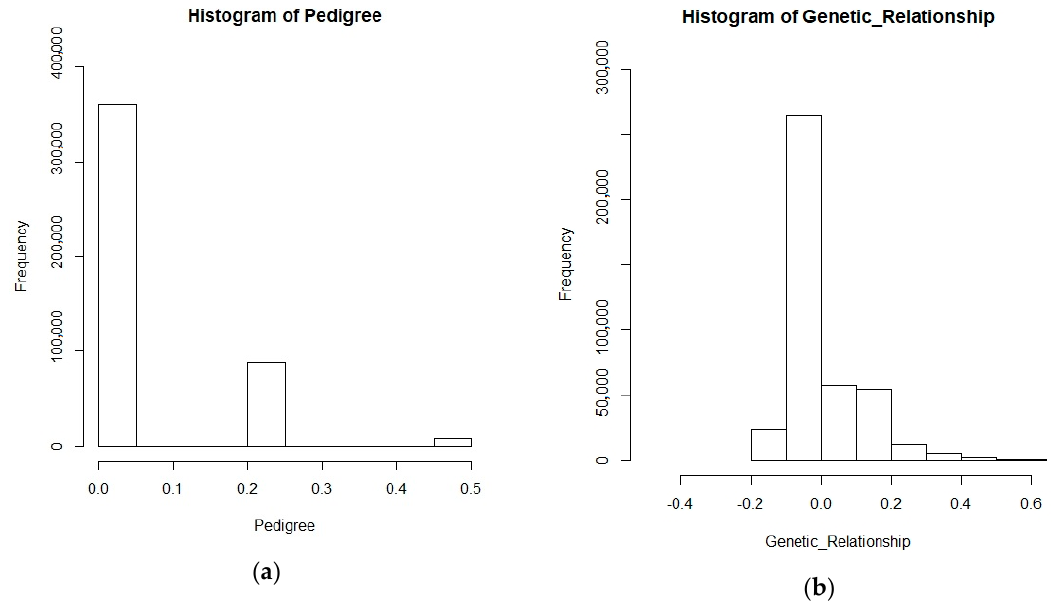
Figure 1. Distribution of pedigree ( a ) and genetic relationship values ( b ) for the breeding population studied.